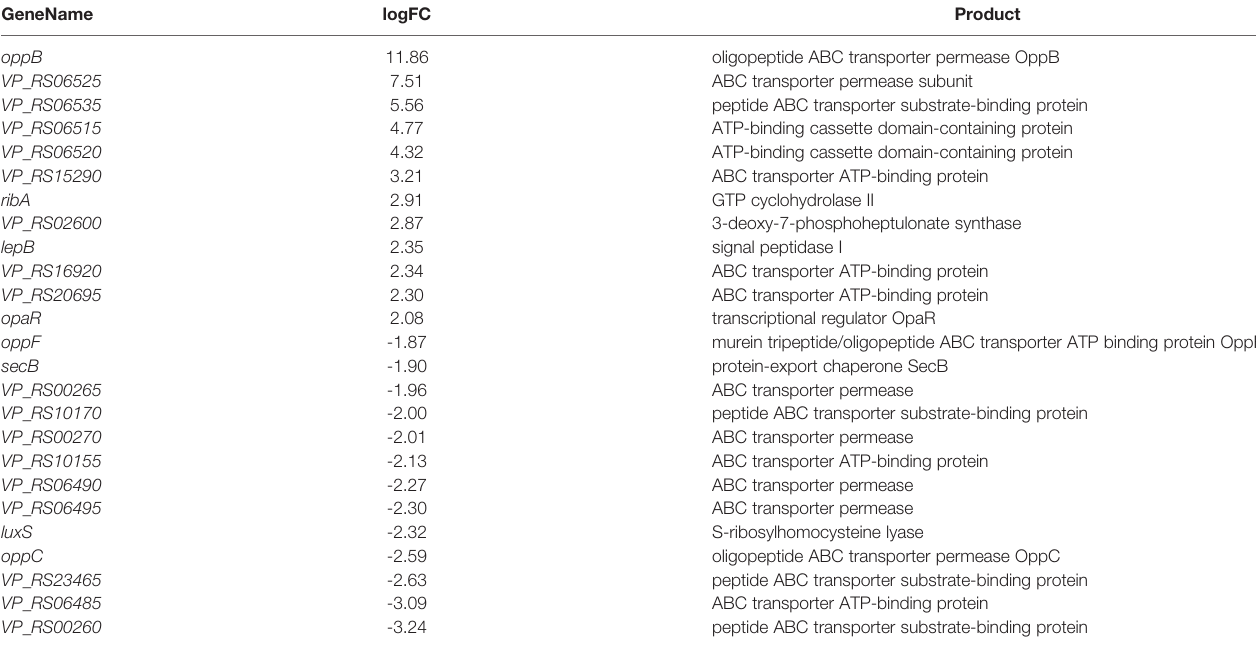
TABLE 2 | Analysis of differential gene expression of quorum sensing. GeneName